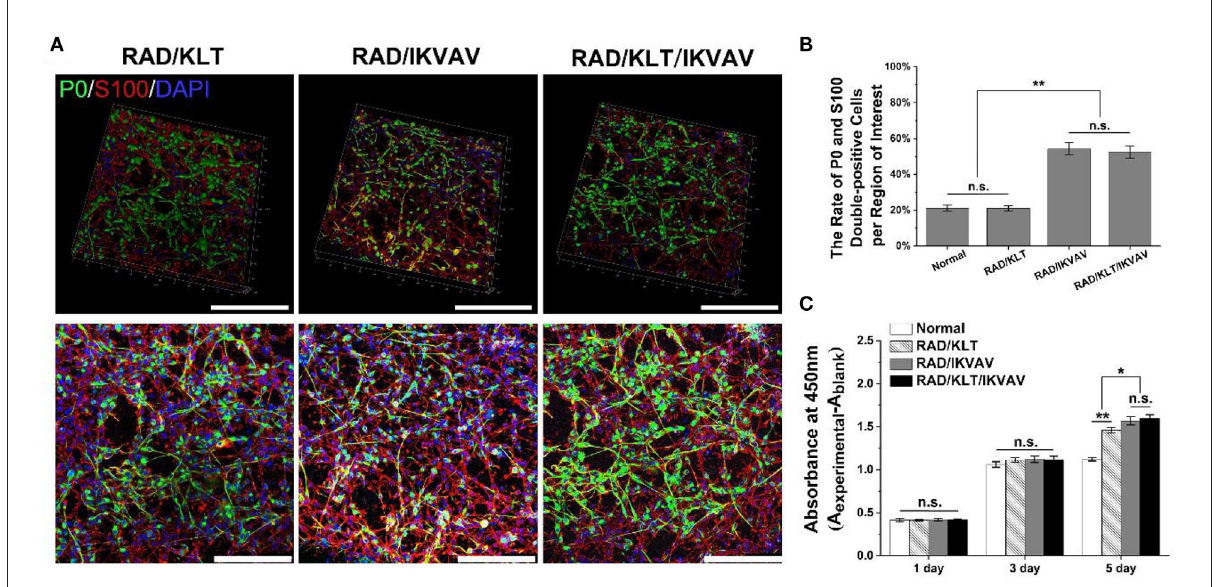
FIGURE2 Effect of peptide gels on proliferation and differentiation of Schwann cells. (A) Representative immunofluorescence staining images of SCs from each peptide gels. The top row is the 3D views and the bottom row are the maximum projectional views. (B) The rate of P0 and S100 double-positive cells per region of interest in each group. (C) The CCK-8 assay results of SCs in each groups. Data are expressed as means ± SEM. * p < 0.05, ** p < 0.01, n.s. represents no significant difference, one-way ANOVA with Tukey’s post-test or Dunnett T3’s post-test. Scale bar = 200 µ